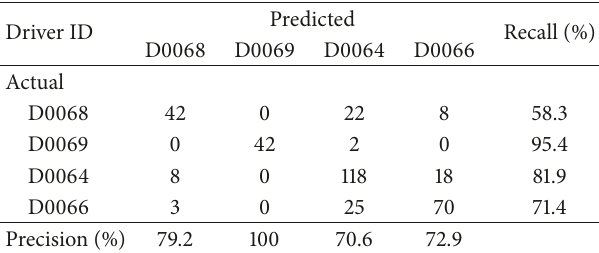
Table 6: Accuracy and confusion matrix on group 6 (G6) of drivers for 10-fold cross-validation.